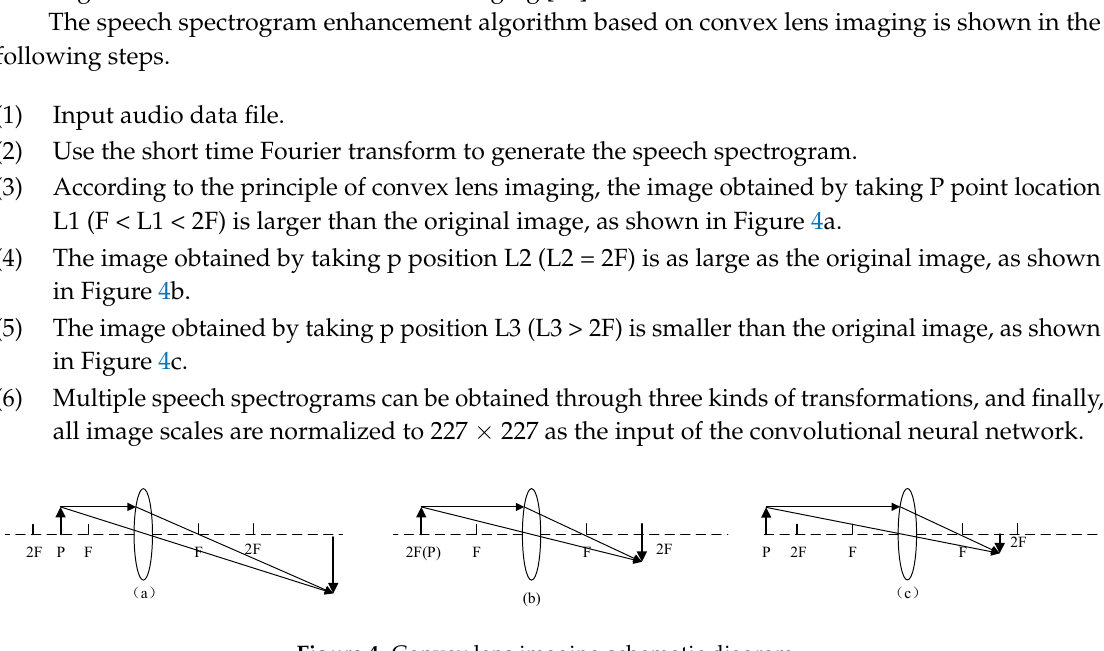
Figure 4. Convex lens imaging schematic diagram.